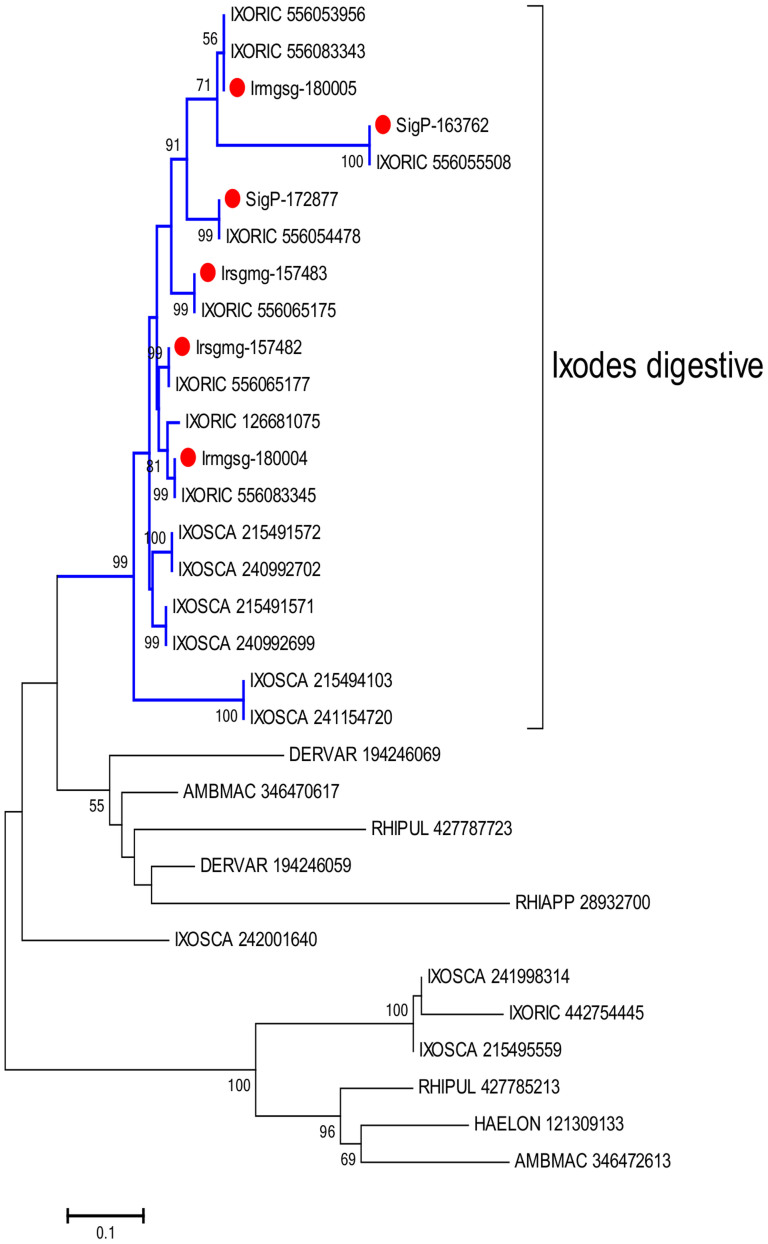
Phylogeny of the cathepsin B family of tick proteases.Multiple protein sequence alignments of all the cathepsin B proteins from ticks was used to construct a phylogenetic tree of the specific family. The red symbols indicate the six enzymes overexpressed in the midgut of Ixodes ricinus (found as overexpressed in this work) beside their GenBank deposited sequence references. GenBank sequences are recognizable by the three first letters of their genus name followed by the first three letters of the species name followed by their GenBank accession number (IXORIC: Ixodes ricinus, IXOSCA: Ixodes scapularis, DERVAR: Dermacentor variabilis, AMBMAC: Amblyomma maculatum, RHIPUL: Rhipicephalus pulchellus, RHIAPP: Rhipicephalus appendiculatus, HAELON: Haemaphysalis longicornis). The numbers near the branches indicate the percentage of bootstrap support using the neighbor joining algorithm. Values lower than 50 are not shown. The bar at the bottom indicates 10% amino acid substitution rate.